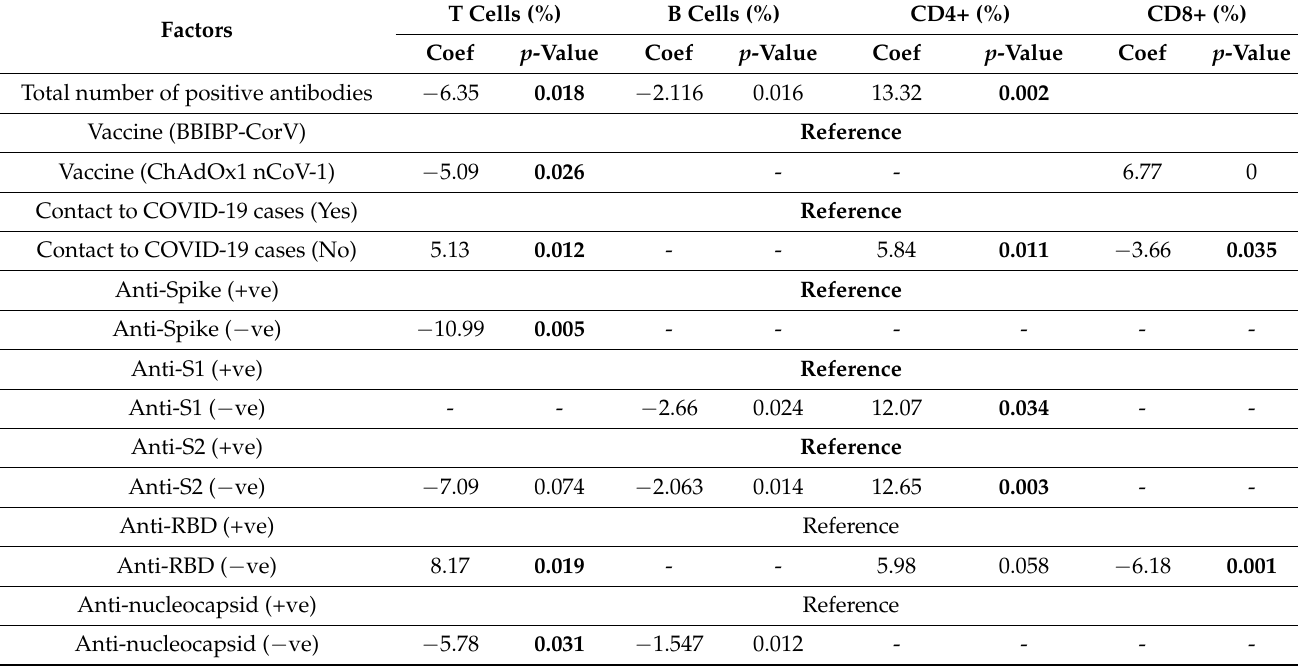
Table 4. Factors affecting cell-mediated immune response after vaccination.